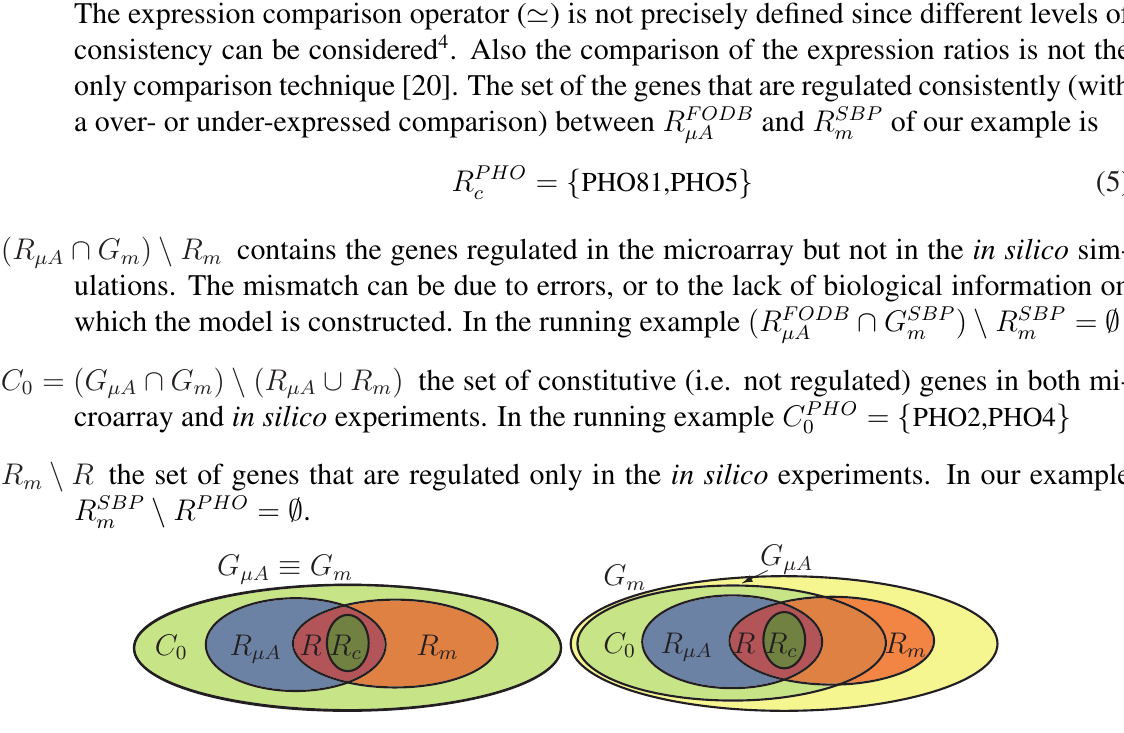
Figure 4: Representation of G µA , G m , R µA and R m assuming G m ≡ G µA and G µA ⊆ G m